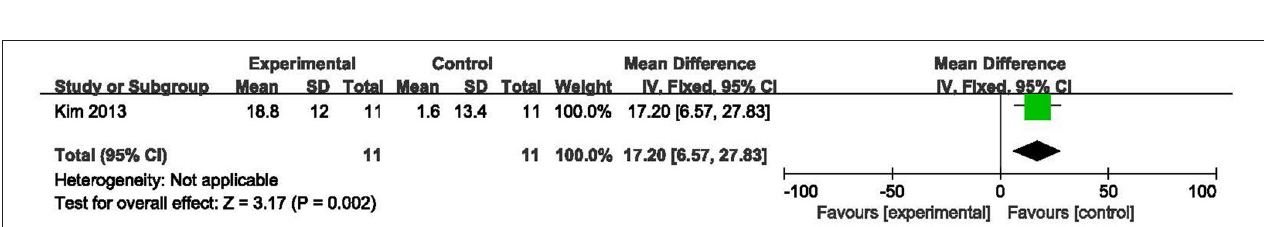
FIGURE 5 | Forest plot of network meta-analysis of the end-of-treatment effect on post-traumatic stress disorder symptom severity between mindfulness-based stretching and deep breathing exercise and no treatment.